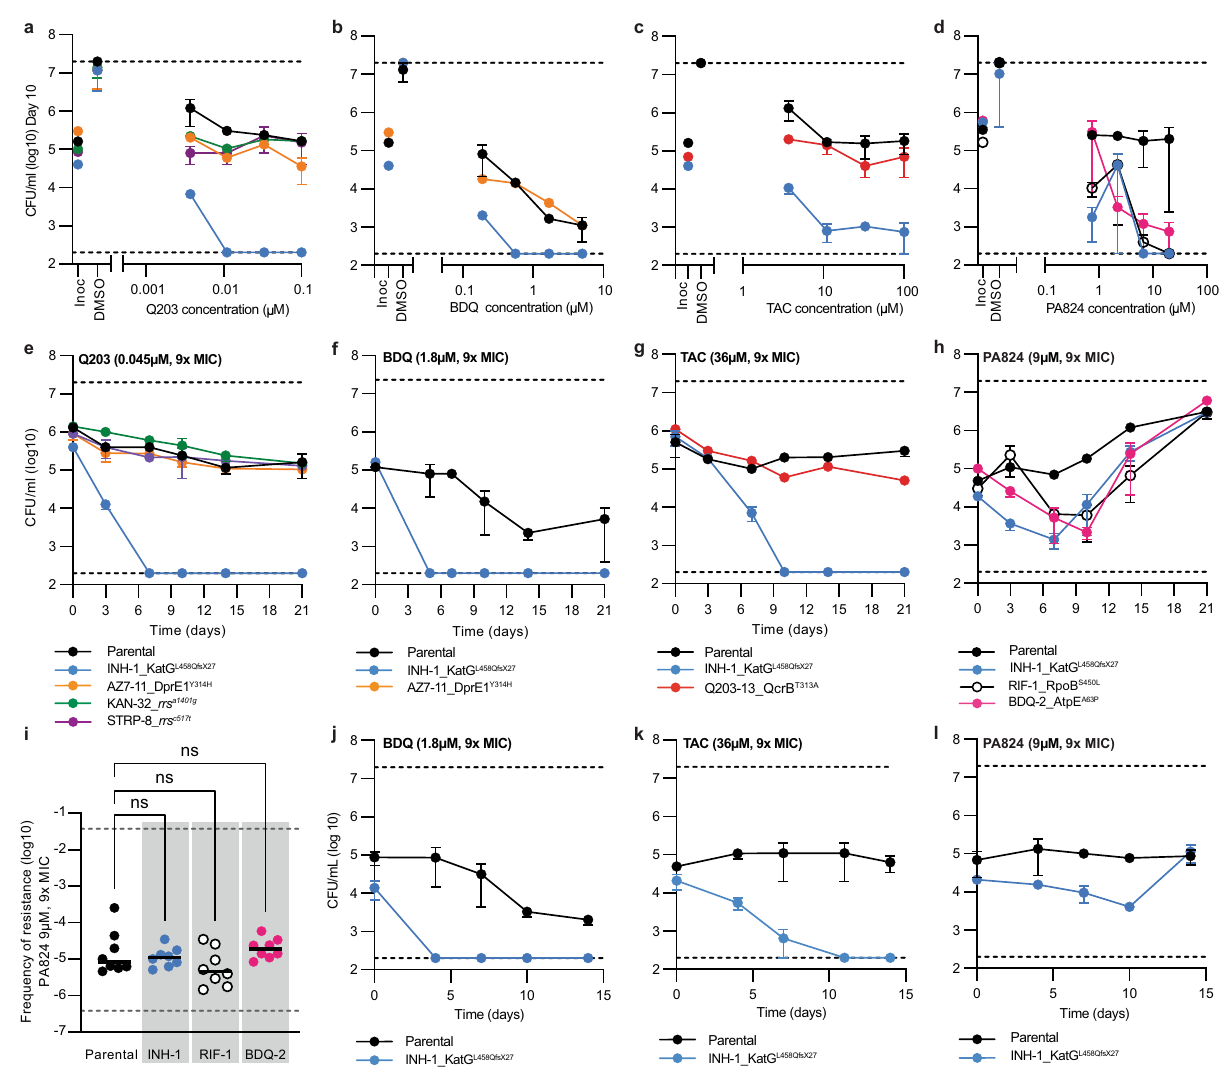
Fig. 4 | Altered killing dynamics of drug-resistant variants of M. tuberculosis following exposure to collateral antibiotics. a – d Minimum bactericidal con- centration assays for selected drug-resistant variants and the drug-susceptible parentagainstselectedantibiotics.CFUsweredeterminedatday0andatday10for concentrationsatandabovetheminimuminhibitoryconcentrations(i.e.1,3,9,and 27× MIC of the drug-susceptible parent) of selected compounds. Inoc = starting inoculum onday 0,DMSO=solvent control. e – h Timekill experimentsofselected drug-resistantvariantsandthedrug-susceptibleparentagainstselectedantibiotics at concentrations above the minimum inhibitory concentration (9x MIC). CFUs were taken at stated time points. i Frequency of resistance for selected drug- resistantmutantsanddrug-susceptibleparentalstrainagainst9×PA824.Statistical signi fi cance was investigated using a one-way ANOVA and corrected for multiple